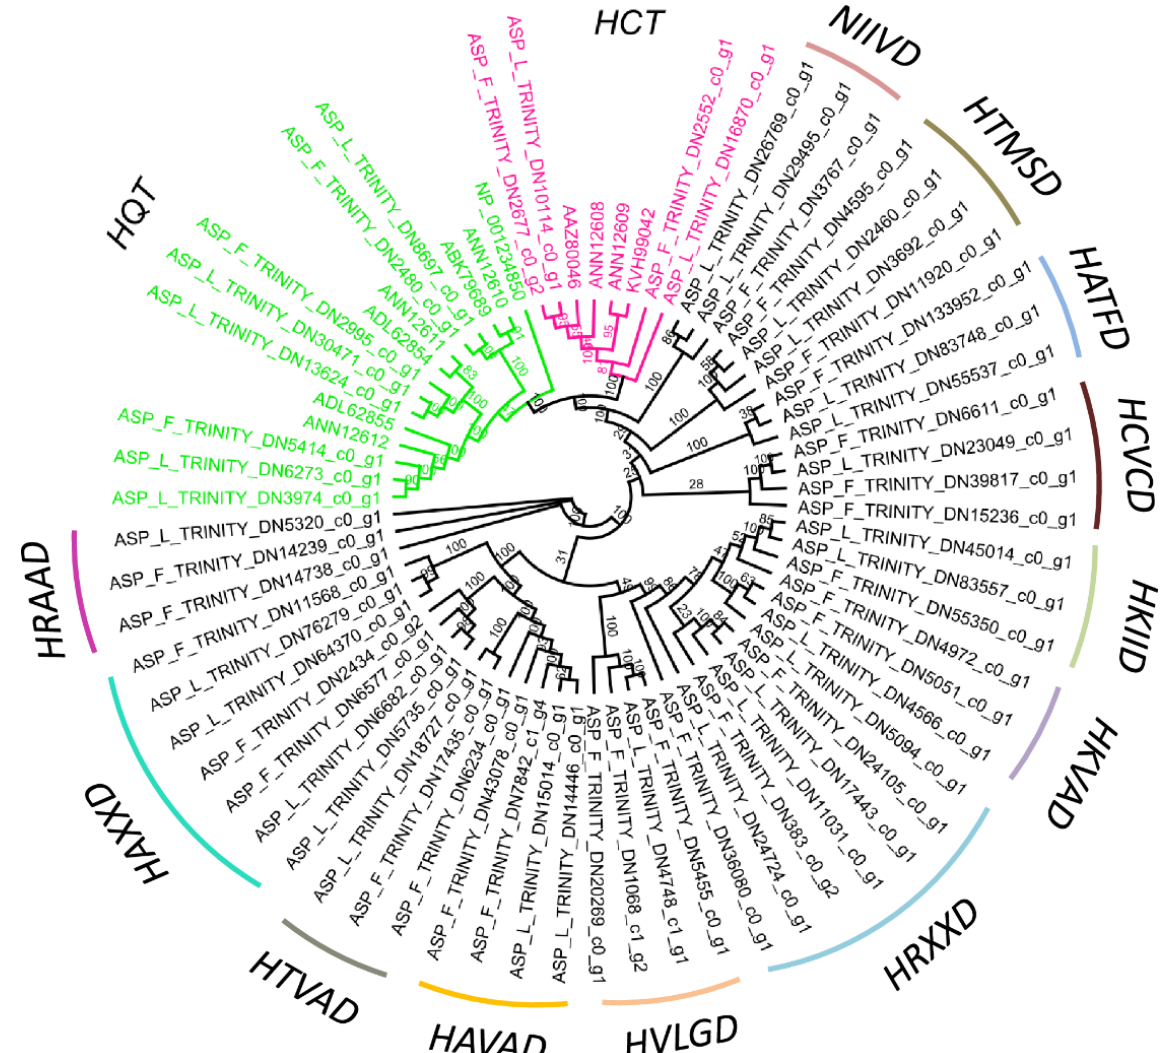
Figure 4. Phylogenetic tree shows the different type of upregulated HXXXD among leaf and flower of A. spathulifolius .